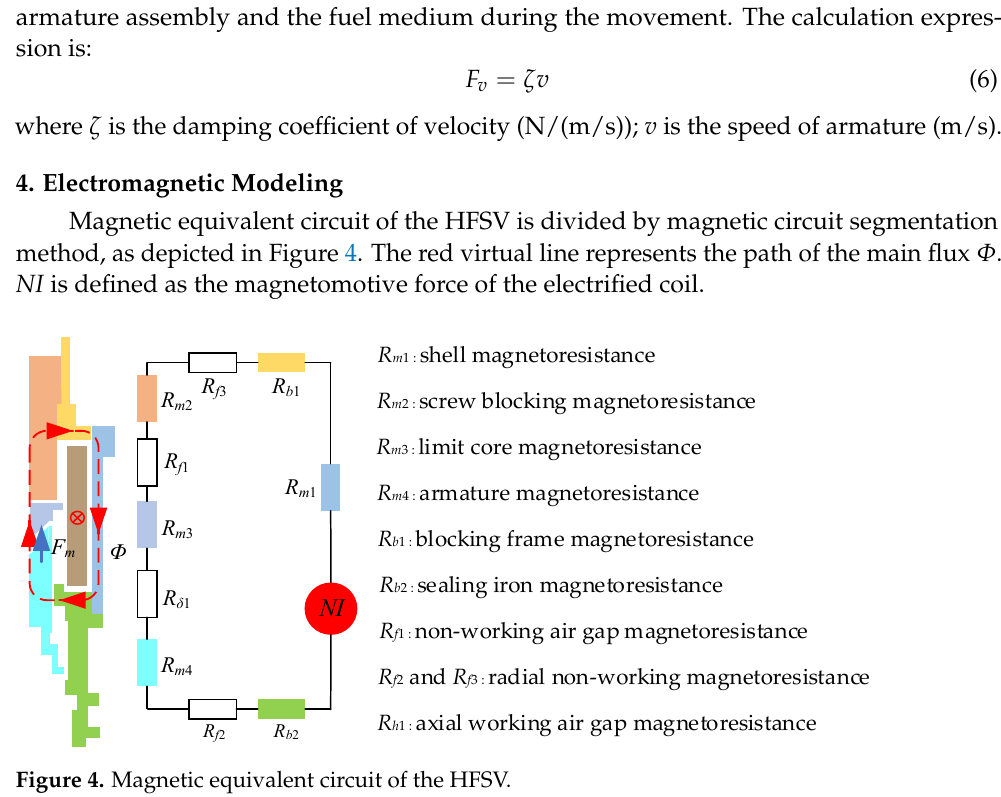
Figure 4. Magnetic equivalent circuit of the HFSV.